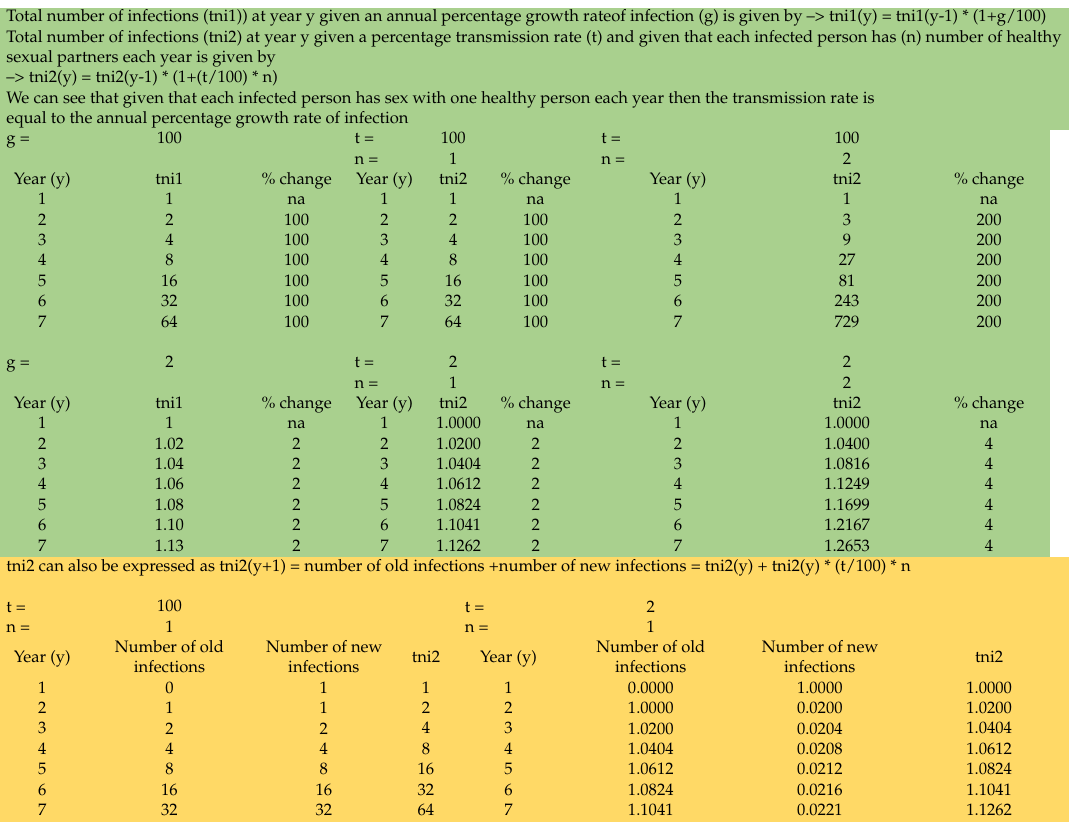
Table 5. The transmission rate for an STD and its relationship to the annual growth rate of